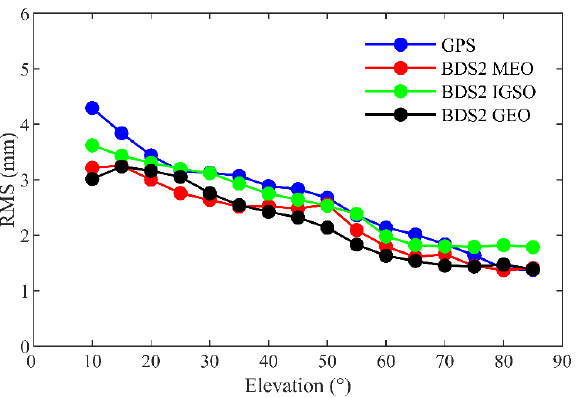
Figure 7. Noise levels of GPS and BDS2 carrier phase observations from TH-2A as a function of the elevation angle.